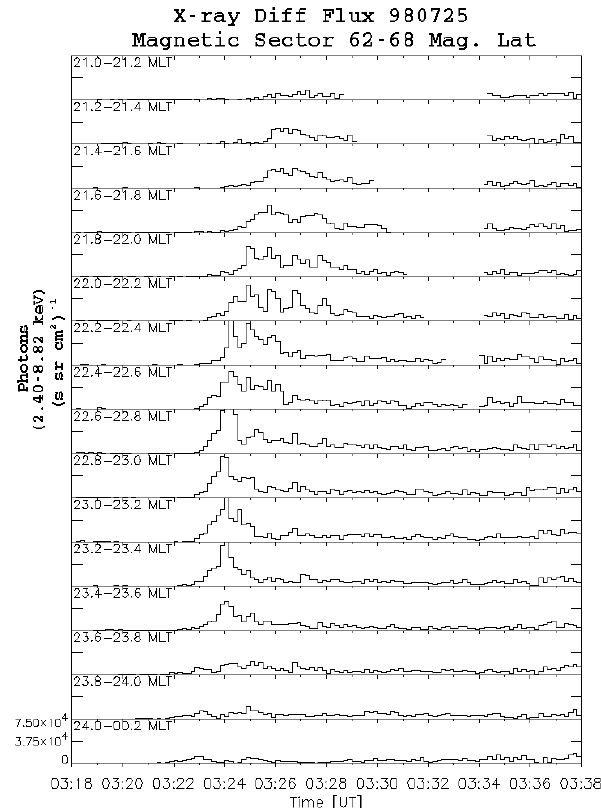
Fig. 5. Time development of X-ray fluxes (2.40–8.82keV) for sev- eral MLT sectors. Fluxes are integrated for 10s, from 62 ◦ –68 ◦ lati- tude which covers the whole latitudinal range of the